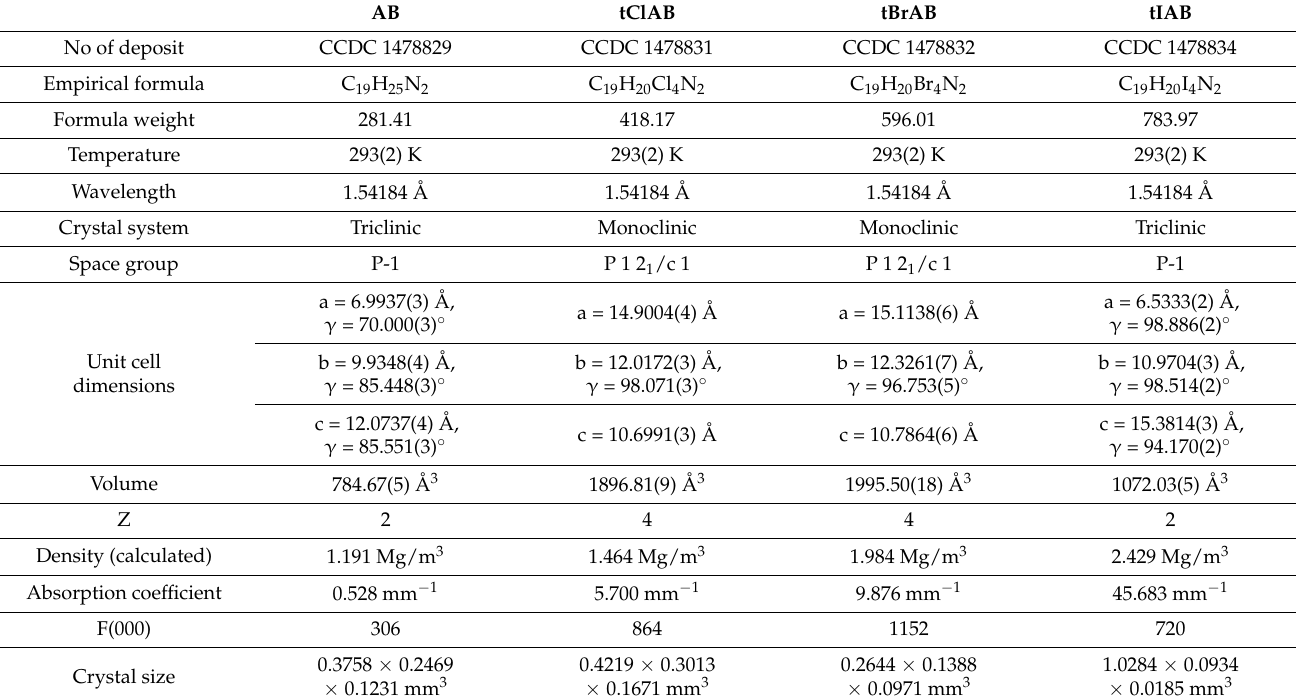
Table 1. Crystal data and structure refinement for AB, tClAB, tBrAB and